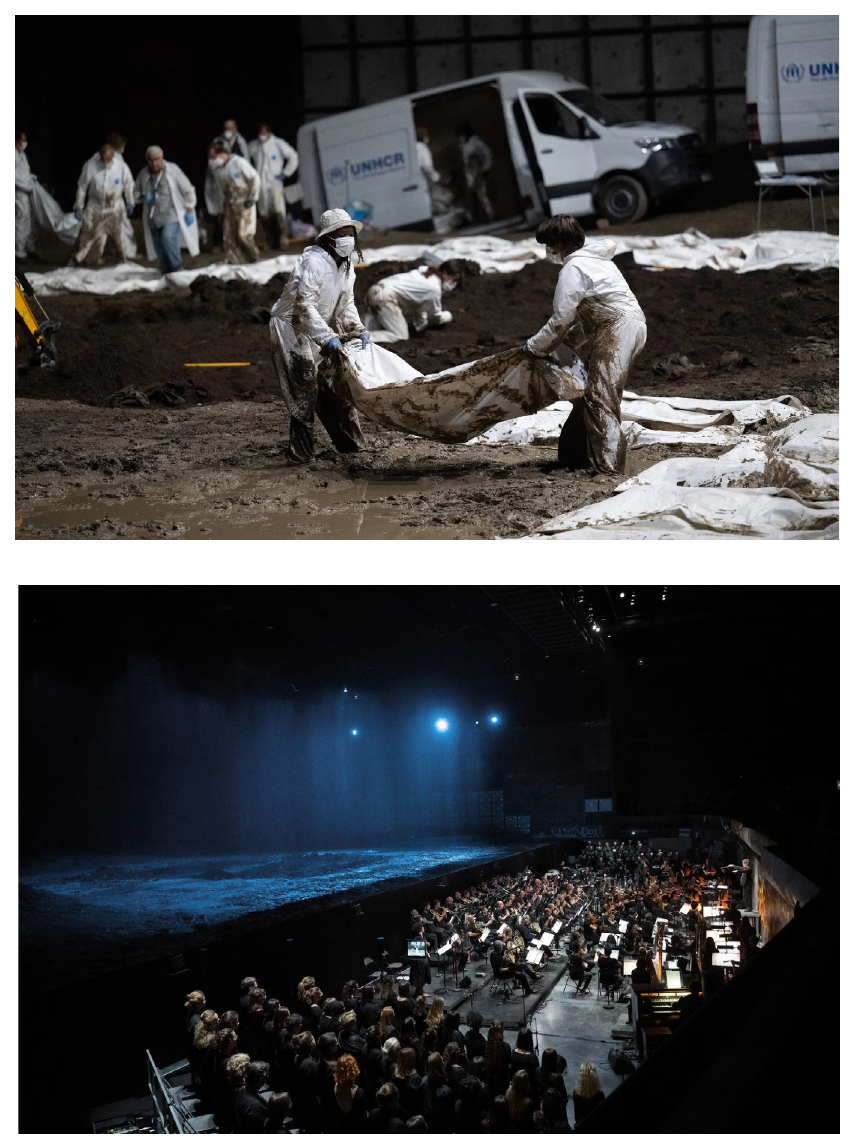
Figg. 5 and 6 – Romeo Castellucci, Resurrection , Aix-en-Provence Festival. Photo credit: Monika